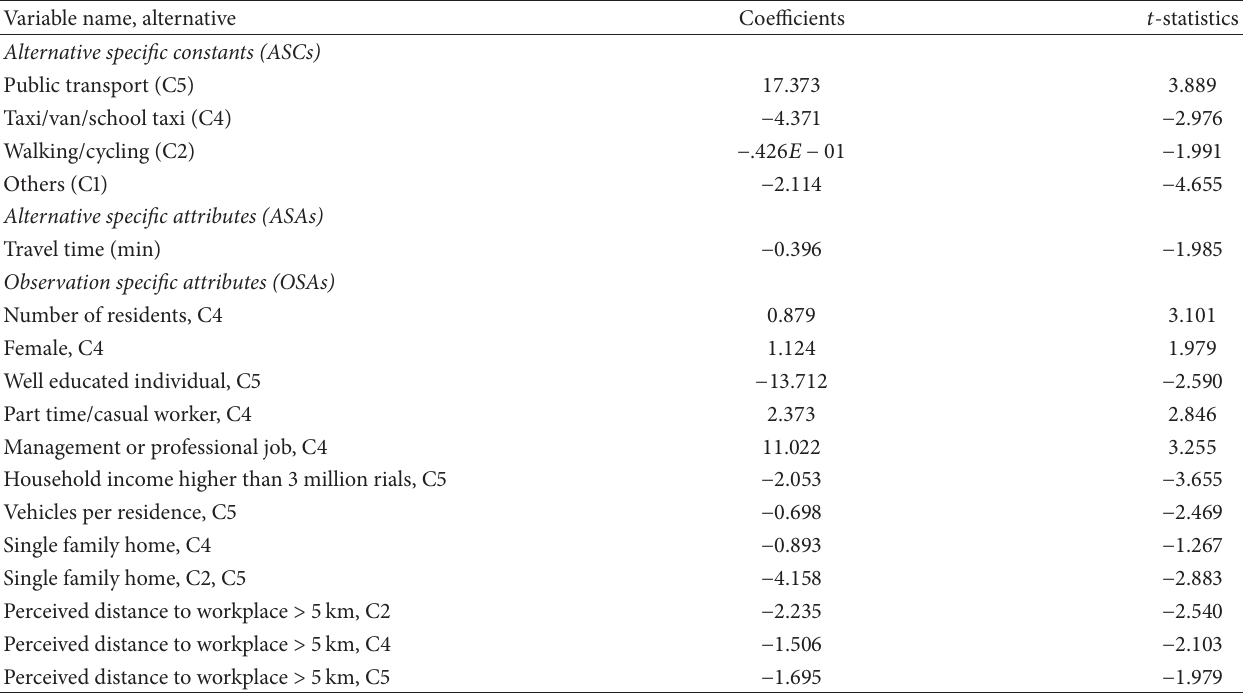
Table 4: The work trip modal choice (all three